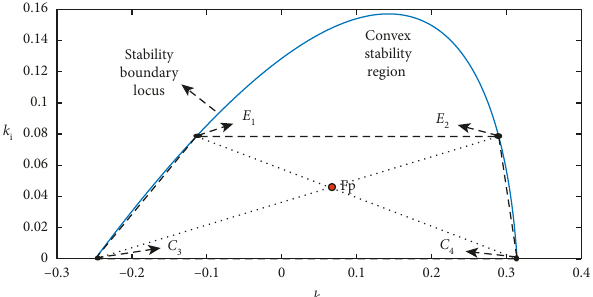
Figure 3: Convex stability region and Fermat point of PI controller in example A.